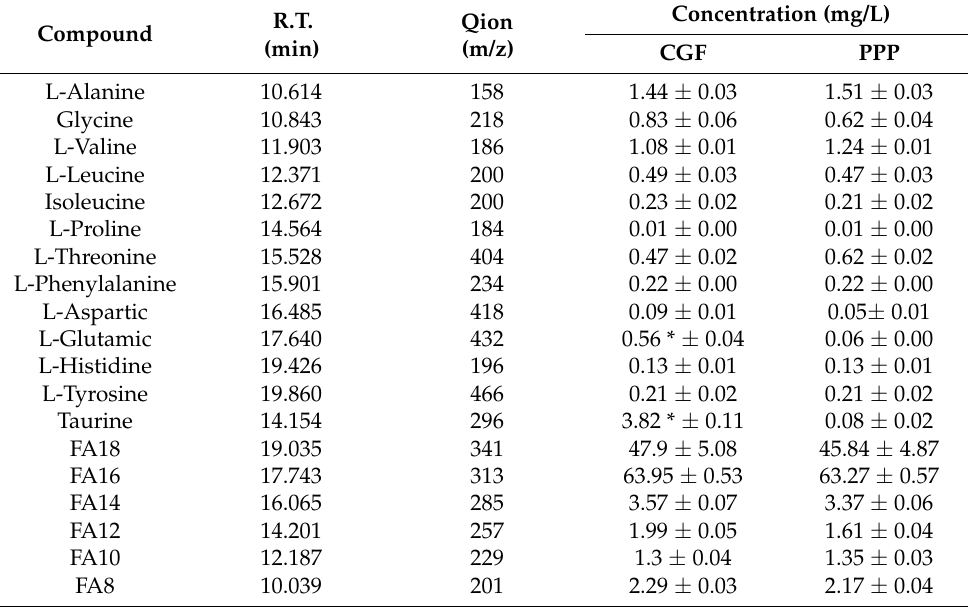
Table 1. Metabolites with their respective concentrations identified in the CGF and PPP fractions. Concentration of metabolites expressed as mg/L. Compound